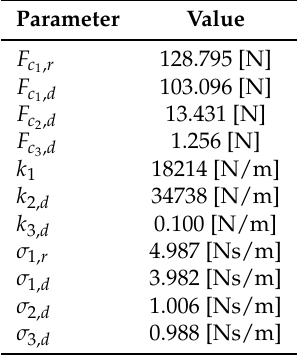
Figure 7. Values of the cost function vs. iteration number of the identification of the ( a ) eleven-parameter model and ( b ) eighteen-parameter model over the rising phase of motion. Table 2. Values of the identified parameters of the extracted